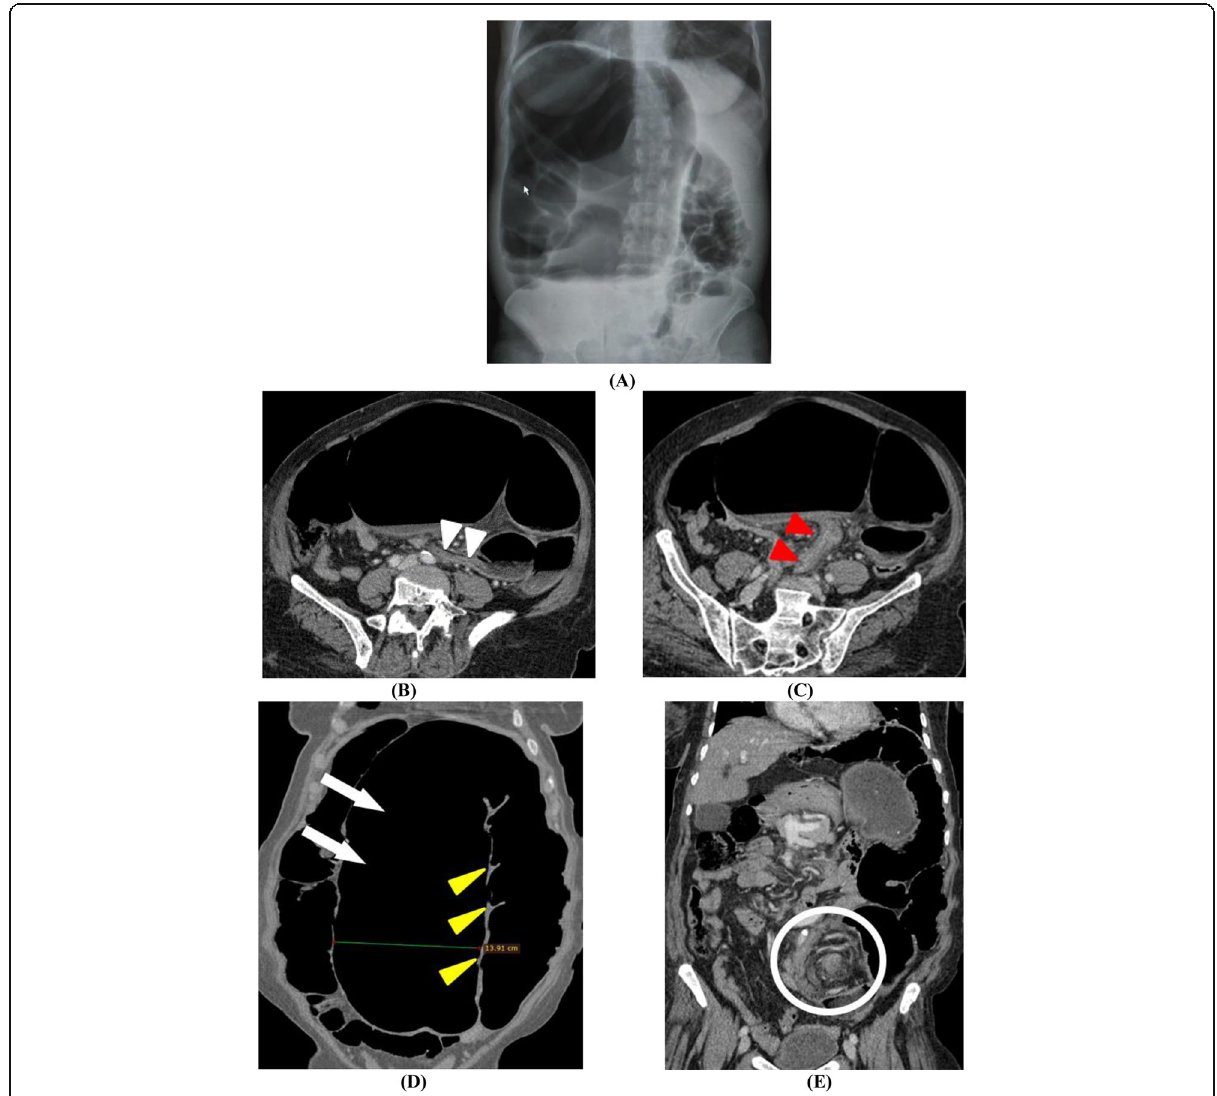
Fig. 9 Sigmoid volvulus in a 75-year-old female patient presented with acute abdominal pain and distension. a Plain erect abdominal film showing distended sigmoid loop with inverted U configuration and coffee bean sign. b Post contrast axial CT image showing a proximal – superior sigmoid transition (white arrowheads). c Post contrast axial CT image showing distal – inferior sigmoid transition (red arrowheads), which is oriented in the direction opposite to the proximal transition. d Coronal CT reformatted image showing markedly dilated gas- and feces-filled sigmoid loop (white arrows) with loss of its haustral markings (yellow arrowheads) and extended from the pelvis way up to the left upper abdomen, giving an inverted U configuration, forming a closed-loop obstruction. e Coronal CT image showing twisting of the mesentery and mesenteric vessels of sigmoid colon, giving a whirl sign